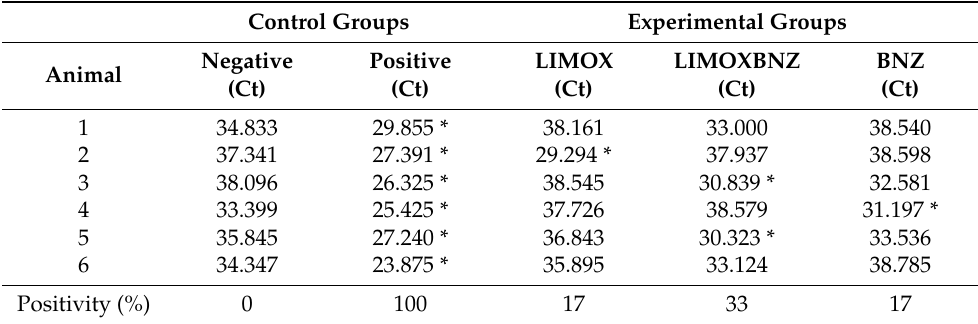
Table 4. Quantification of parasite DNA by real-time PCR of heart tissue from Wistar rats infected with Trypanosoma cruzi and treated with 31 continuous once-daily oral